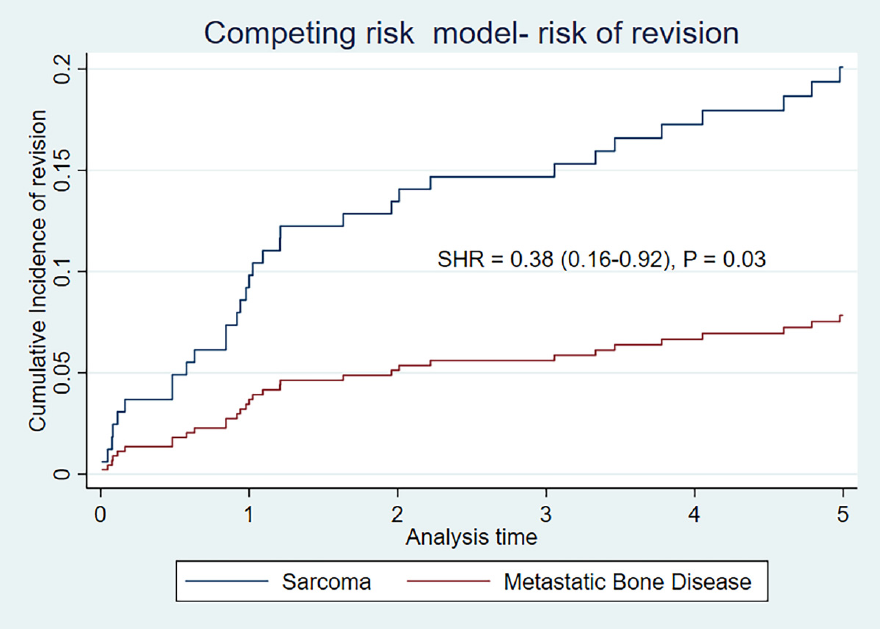
Figure 2. Cumulative incidence of risk of revision by competing risk model (death as competing risk) by indication.